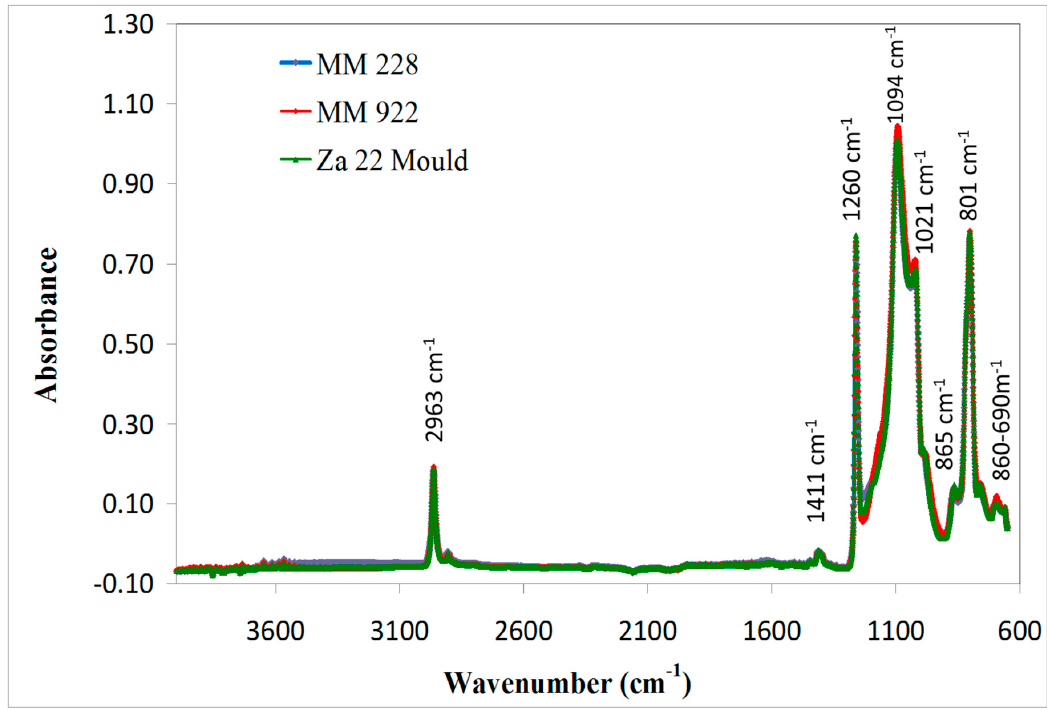
Figure 3. FT-IR spectra of silicone elastomers used to make hybrid silicone-ceramic composites.